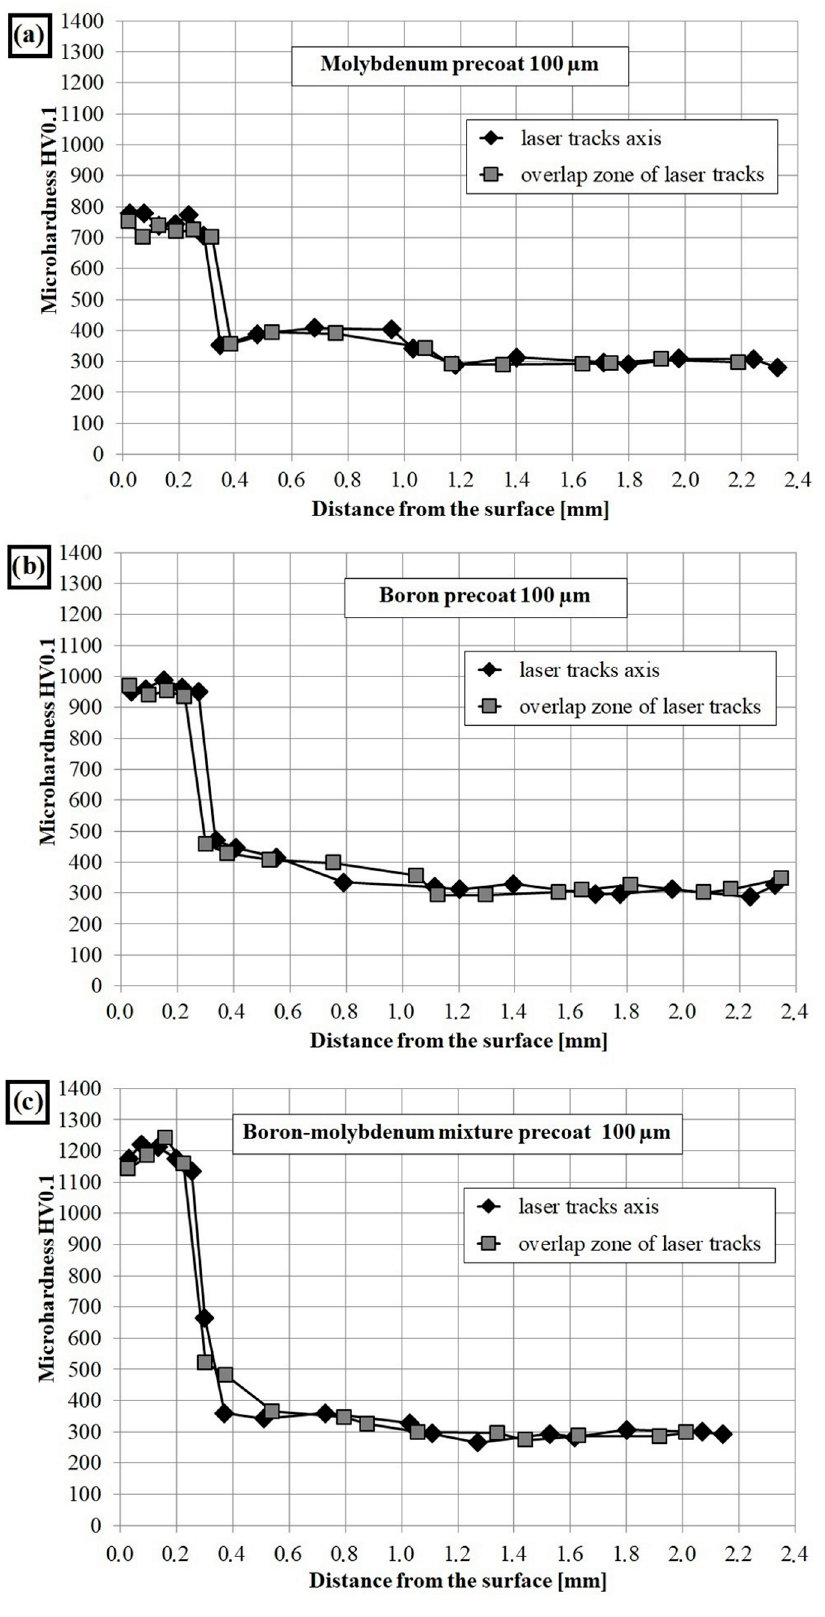
Figure 8. Microhardness of CT90 with laser alloying with pre-coating containing: ( a ) molybdenum; ( b ) boron; ( c ) mixture of boron and molybdenum.